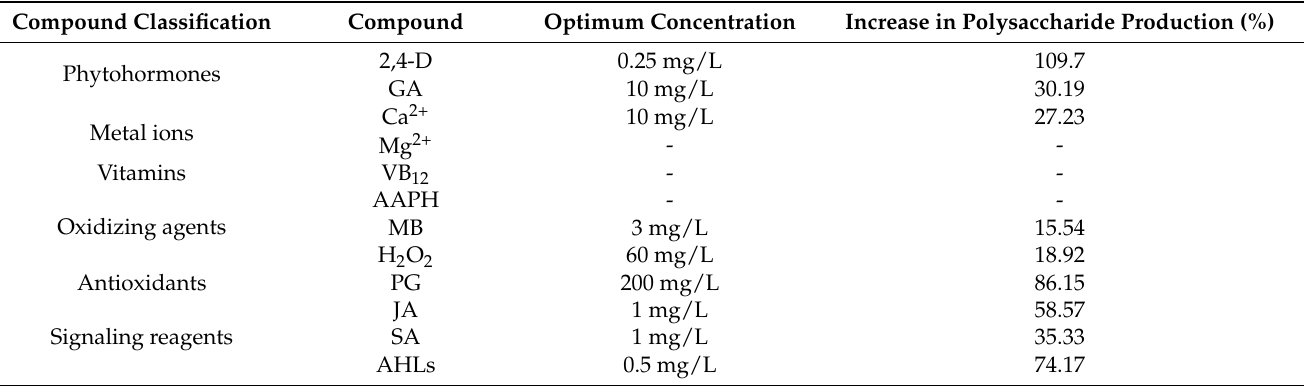
Table 1. The effects of the chemical inducers on the polysaccharides production of N. flagelliforme . Compound